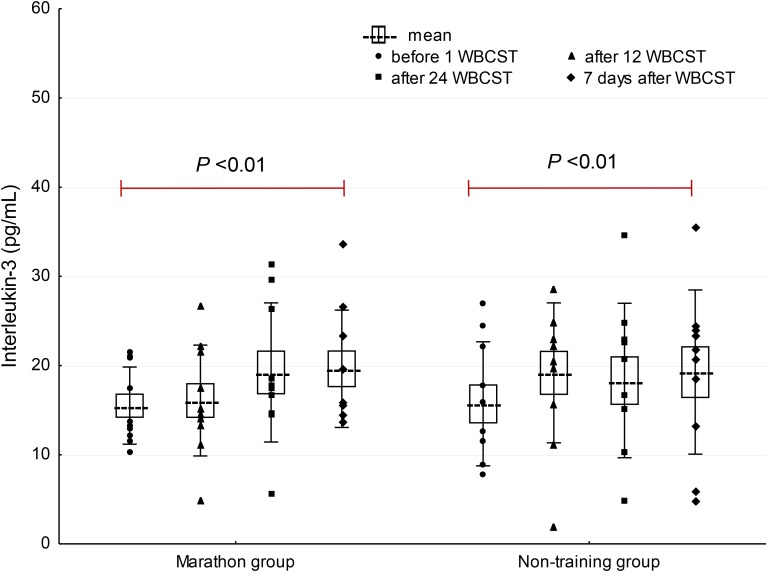
The influence of repeated whole-body cryostimulation (WBCST) treatments on the blood plasma concentration of interleukin-3 in marathon runners and non-training men. Presentation of individual data, mean (---), SE (box), and SD (whiskers).